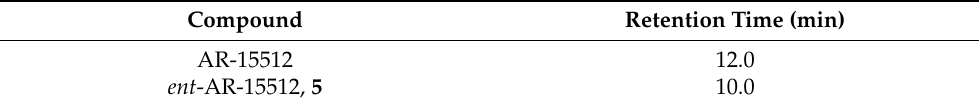
Table 2. Retention times of AR-15512 and its enantiomer 5